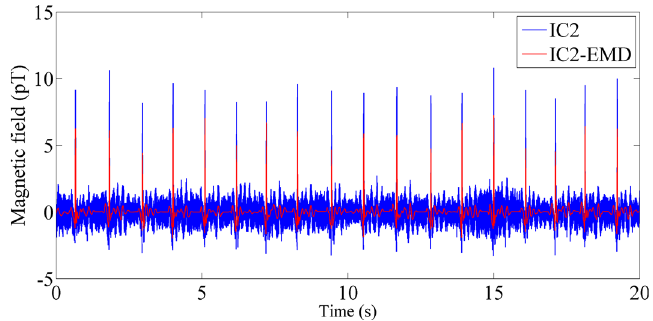
Figure 6. The blue line represents IC2, and the red line represents IC2 denoised by EMD.